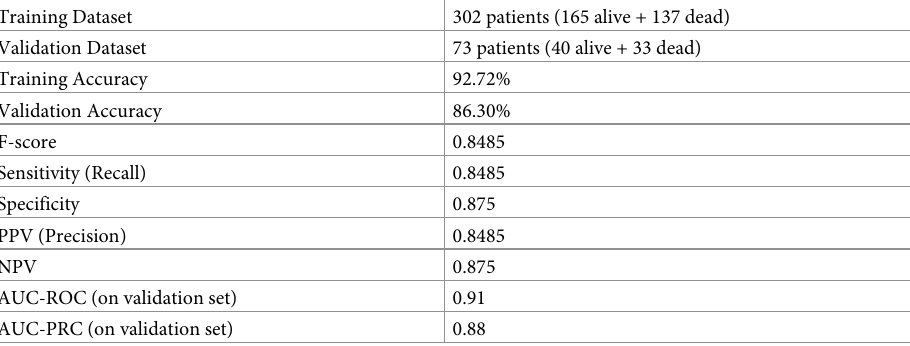
Table 1. Performance of the mortality prediction